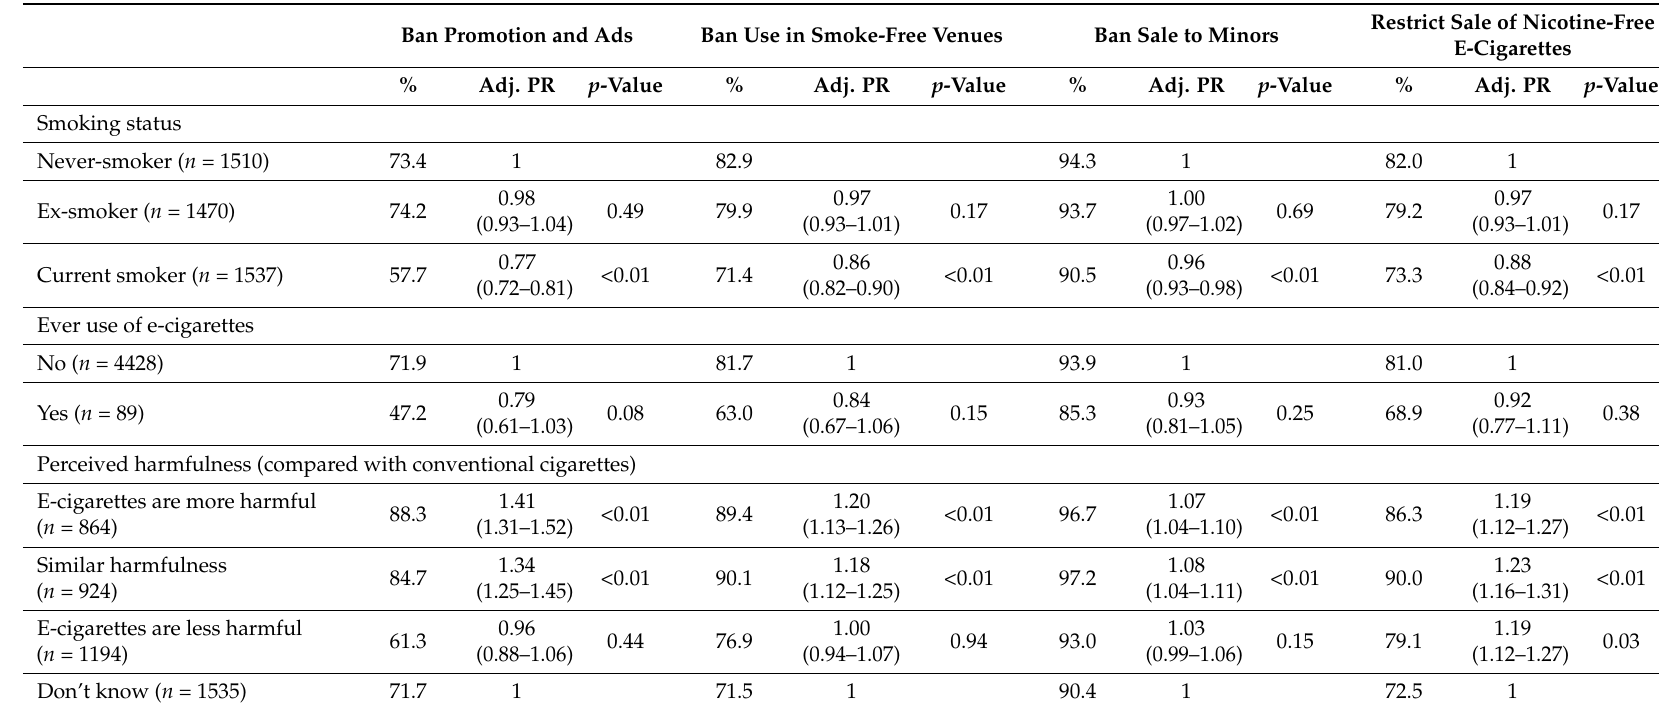
Table 4. Support for e-cigarette regulations by smoking status, ever use of e-cigarettes and perceived harmfulness of e-cigarettes in the respondents who had heard of